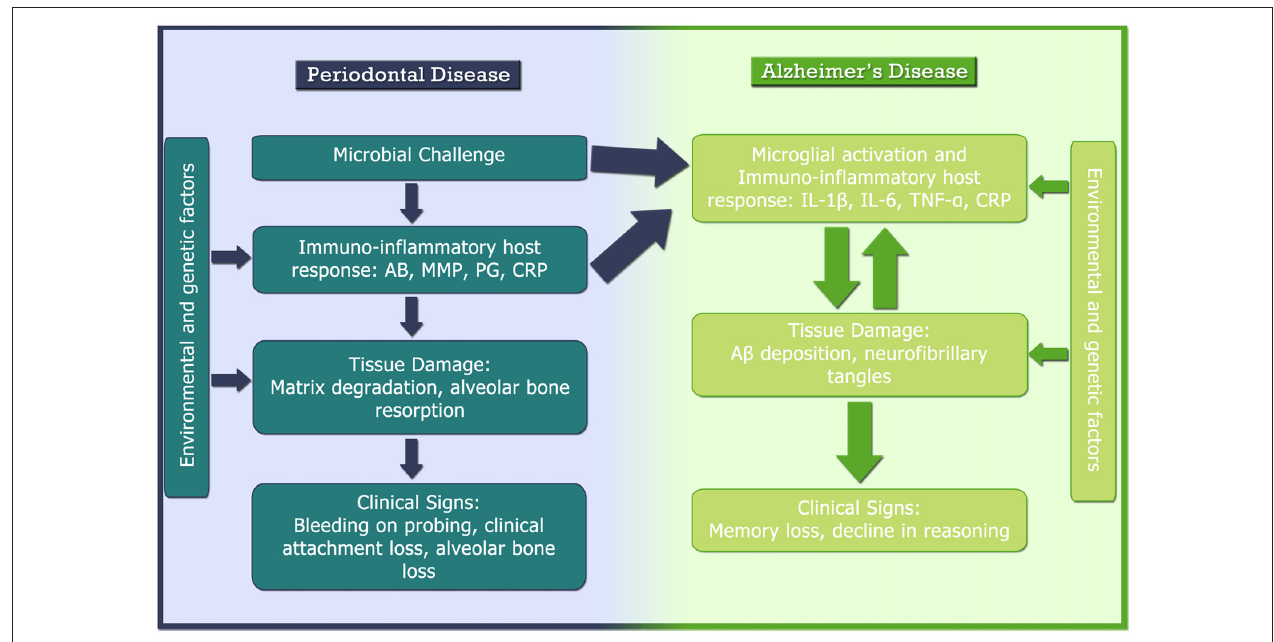
FIGURE 3 | Pathogenesis of AD and periodontal disease and their relationship. AB, antibody; A β , β amyloid protein; BoP, bleeding on probing; CAL, clinical attachment loss; CRP, C-reactive protein; IL, interleukin; MMP, matrix metalloproteinase; PG, prostaglandin; TNF- α , tumor necrosis factor- α